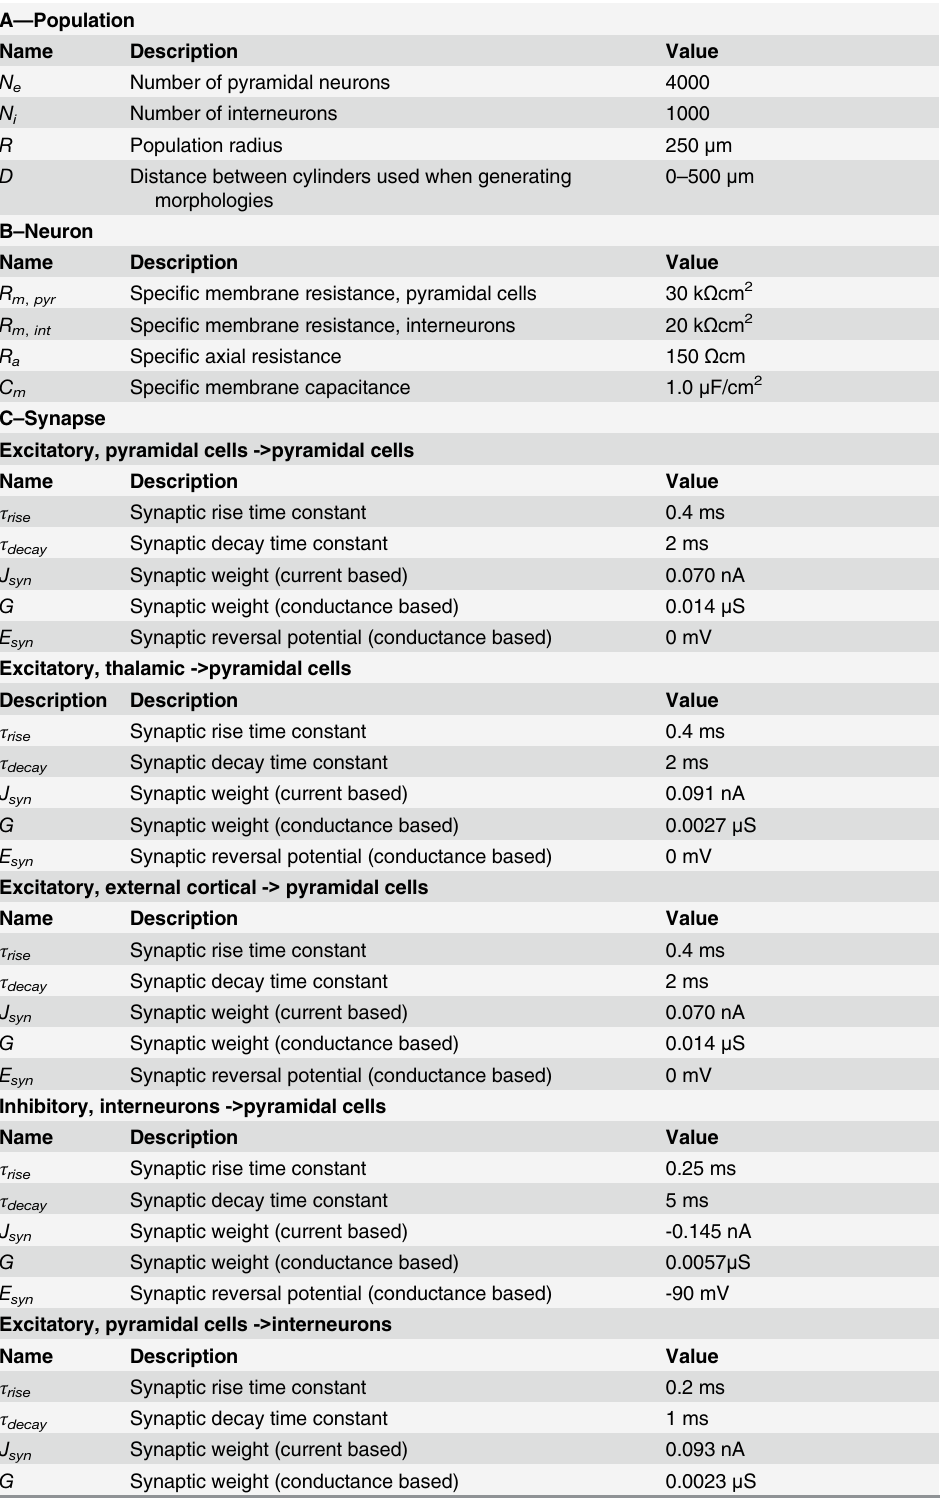
Table 4. Parameter values for the 3D network model of multi-compartmental